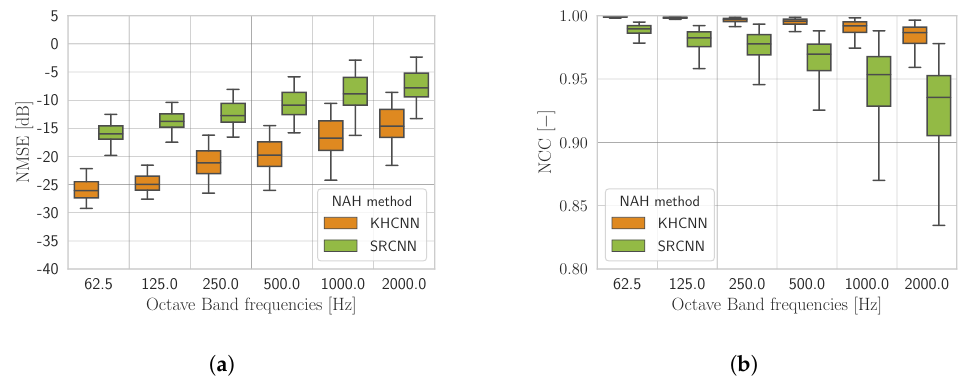
Figure 10. The NMSE ( a ) and the NCC ( b ) comparison between the violin top plate estimates of KHCNN and SRCNN with P ( M = 64 ) at the input. H